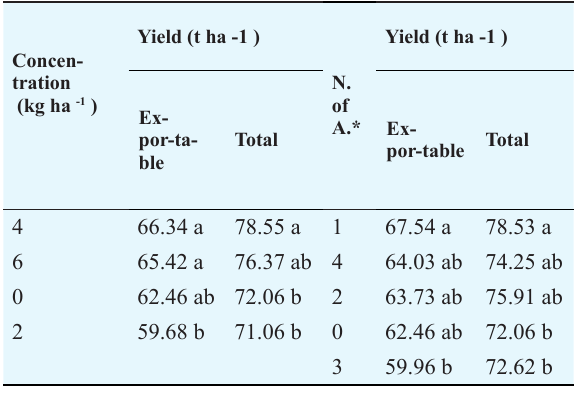
*N. of A.: Number of